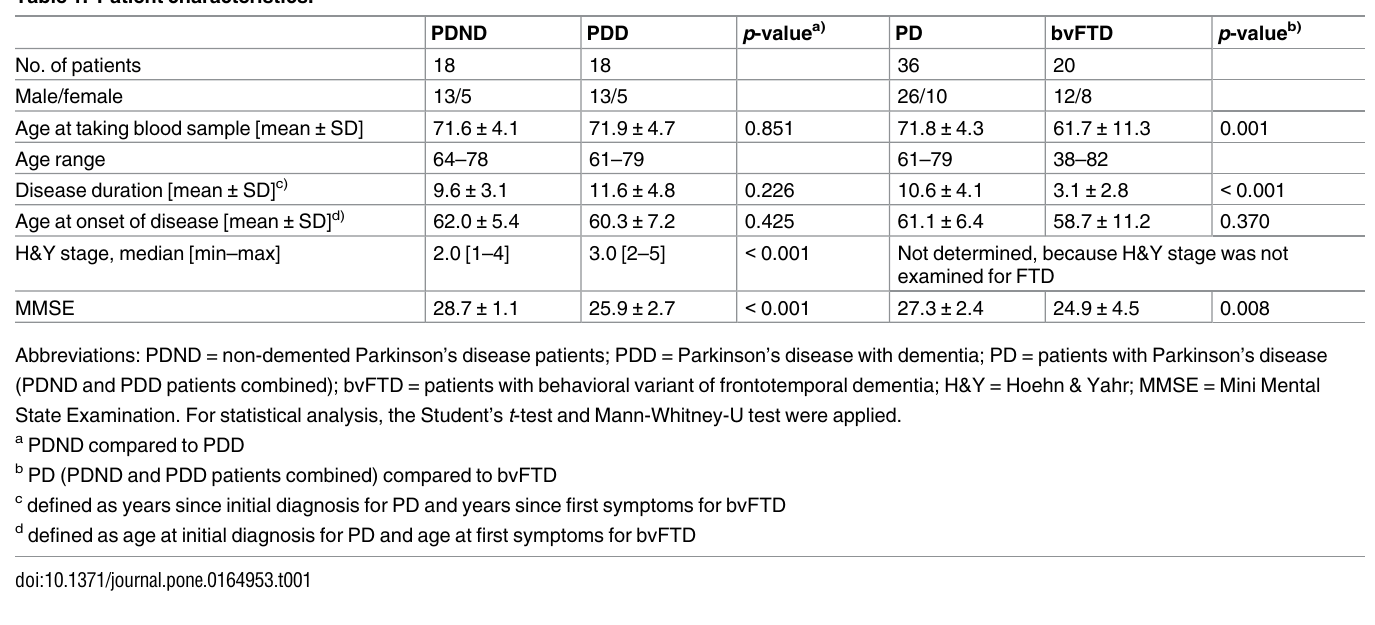
criteria for the diagnosis ‘idiopathic PD’ according to the UK Parkinson's Disease Society Brain